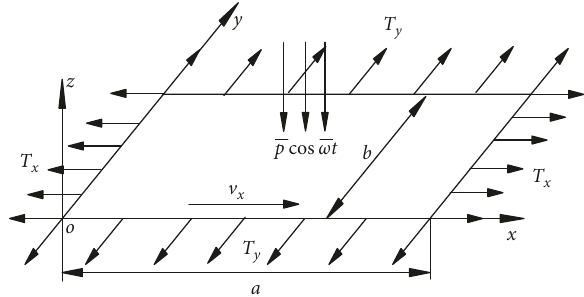
Figure 1: Moving membrane with variable